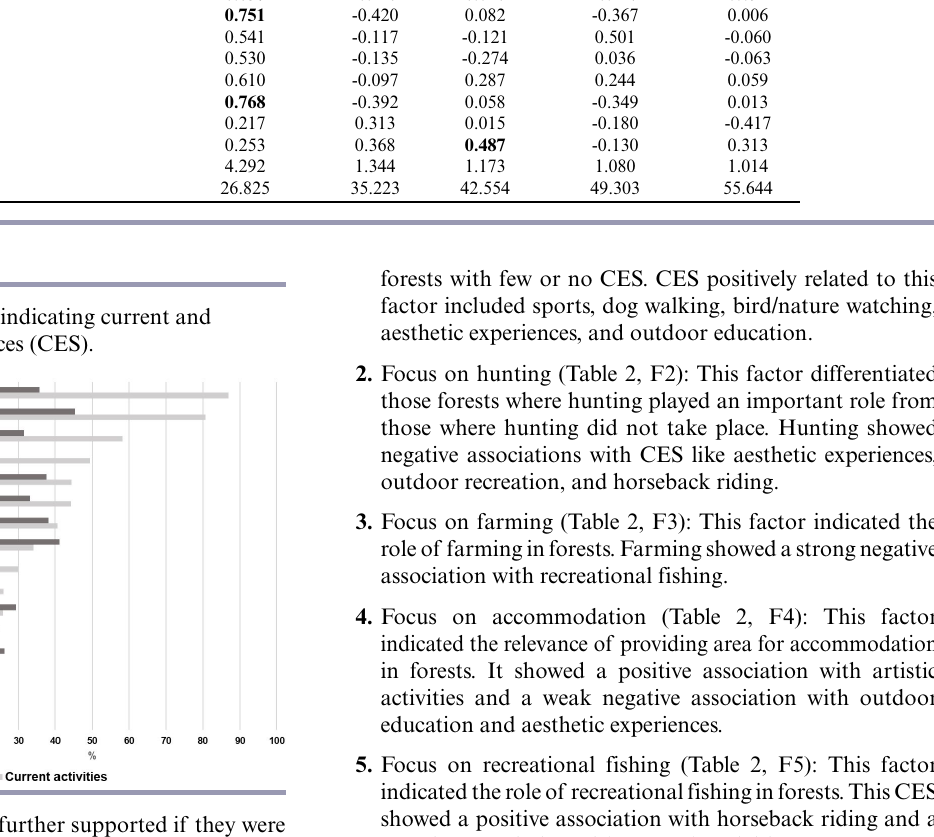
F1 - CES F2 - Focus F3 - Focus F4 - Focus on F5 - Focus simultaneity on hunting on farming accomodation on fishing